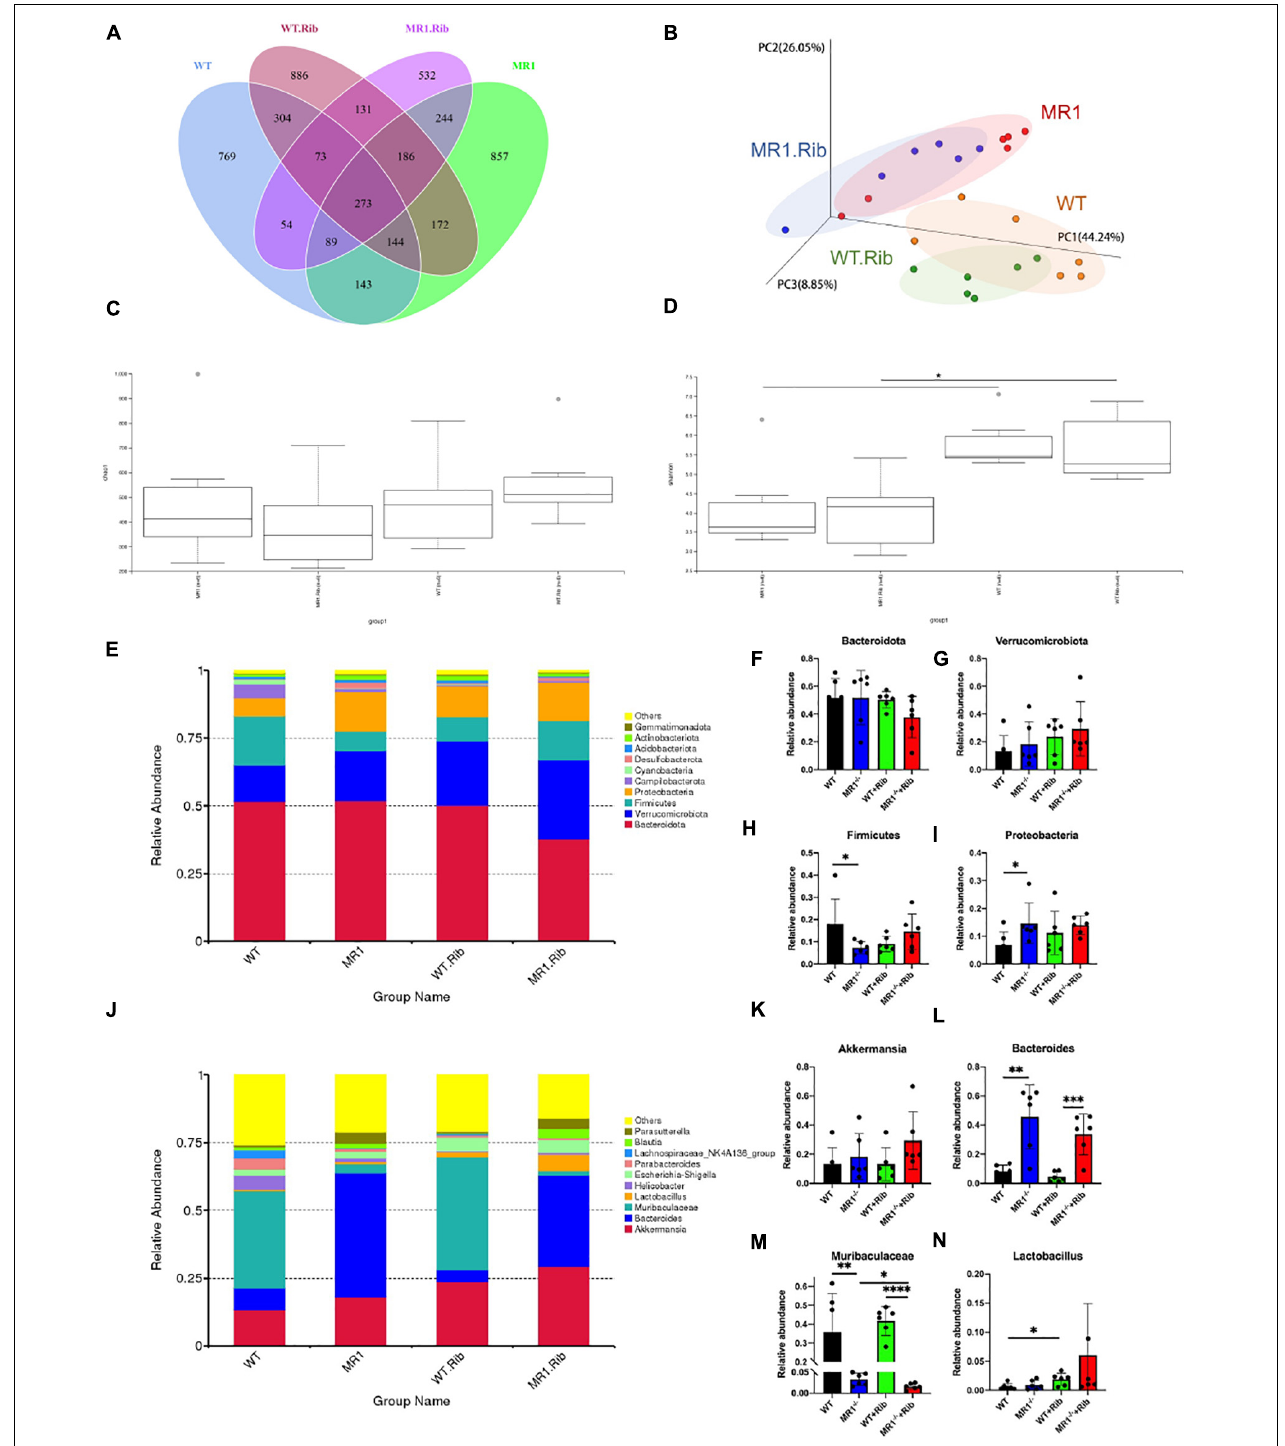
FIGURE 3 | H1N1 infection alters the gut microbiota composition. (A) Venn diagram of the alpha diversity. Each circle represents a group of samples, and the number of overlapping circles represents the number of OTUs shared between groups. (B) PCoA based on weighted UniFrac distances. A closer sample distance indicates greater similarity in the species composition structure. Analysis of Chao1 diversity (C) in the feces of mice. (D) Shannon diversity in the feces of mice. (E) Relative abundance analysis of the top ten phyla in the fecal microbiota. Average bacterial taxonomic profiling at the phylum level. Bacteroidota (F) , Verrucomicrobiota (G) ), Firmicutes (H) , and Proteobacteria (I) were detected in fecal flora through a LEfSe analysis of relative abundance. (J) Genus-level composition of the fecal microbiota. Relative abundance analysis of Akkermansia (K) , Bacteroides (L) , Muribaculaceae (M), and Lactobacillus (N) . ∗ p < 0.05, ∗∗ p < 0.01, ∗∗∗ p < 0.001, ∗∗∗∗ p < 0.0001.